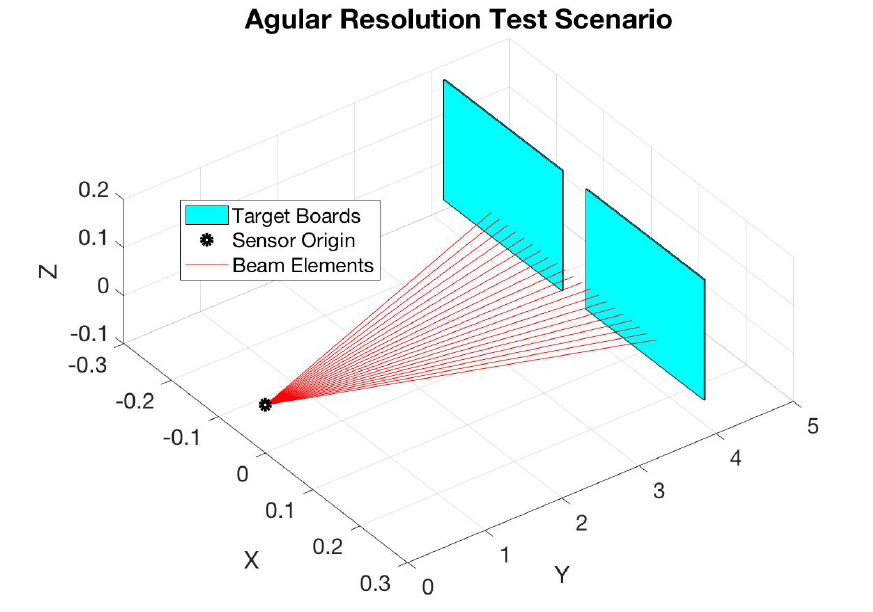
Figure 3. Illustration of target set-up for the angular resolution test relative to laser